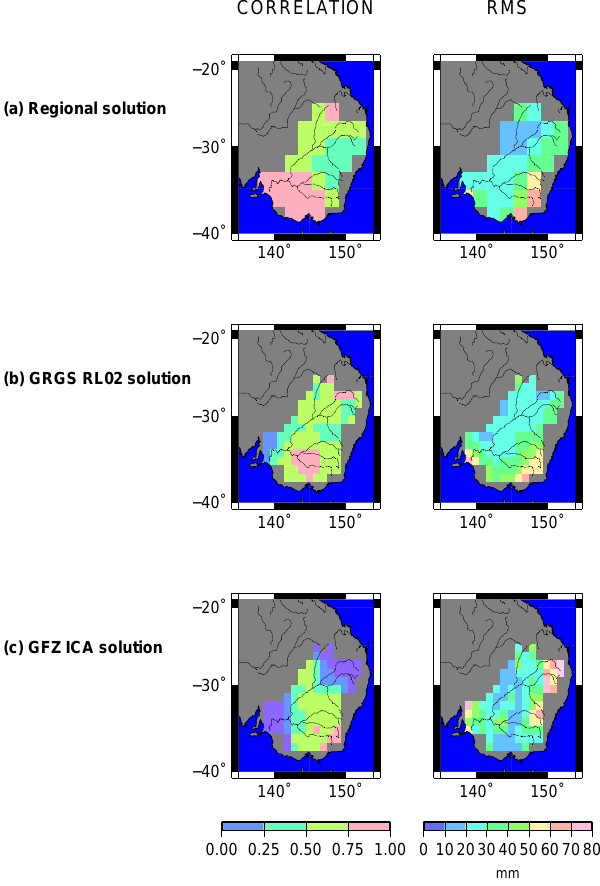
Fig. 16. Spatial correlation (left maps) and RMS (right maps) of differences between TWS (in situ GWS measurements+surface water+modelled soil moisture) and: (a) regional solutions, (b) GRGS RL02 solutions and (c) ICA 400km-filtered solutions.